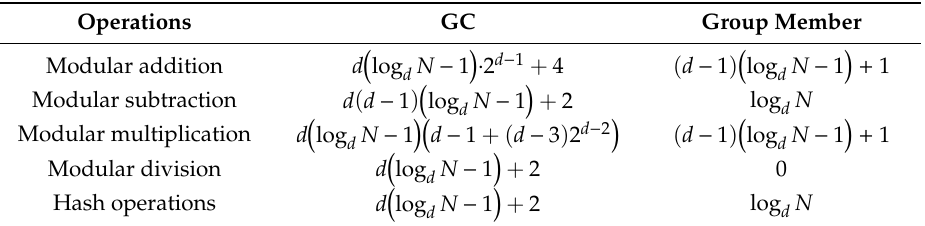
Table 2. CEGKD computation cost under Method 2.